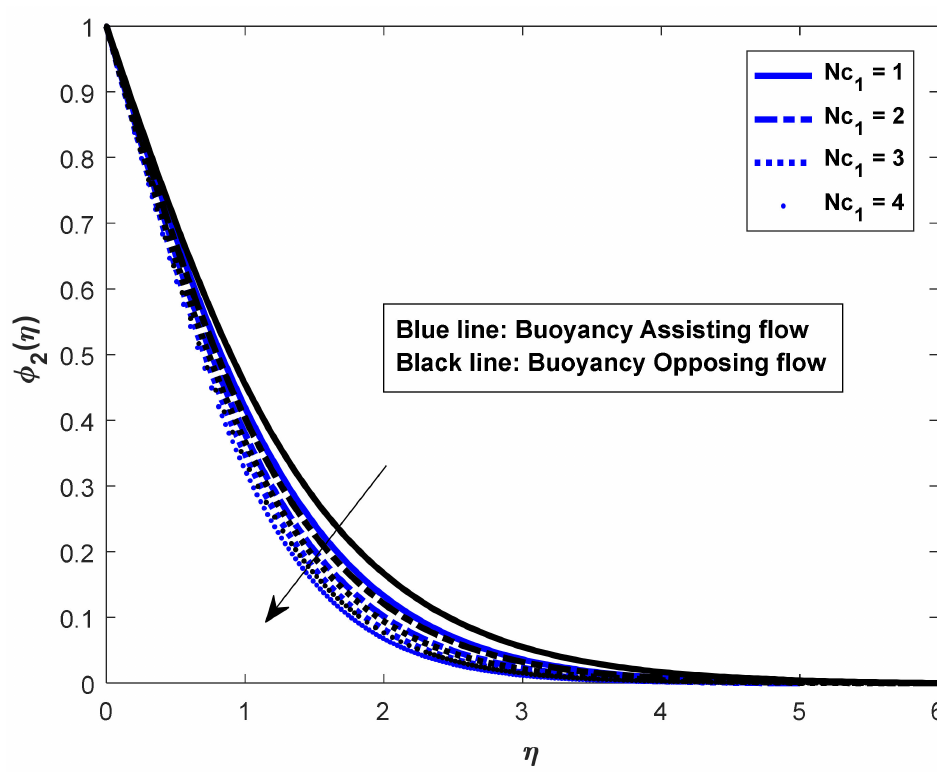
Figure 12. Nc 1 on salt_2